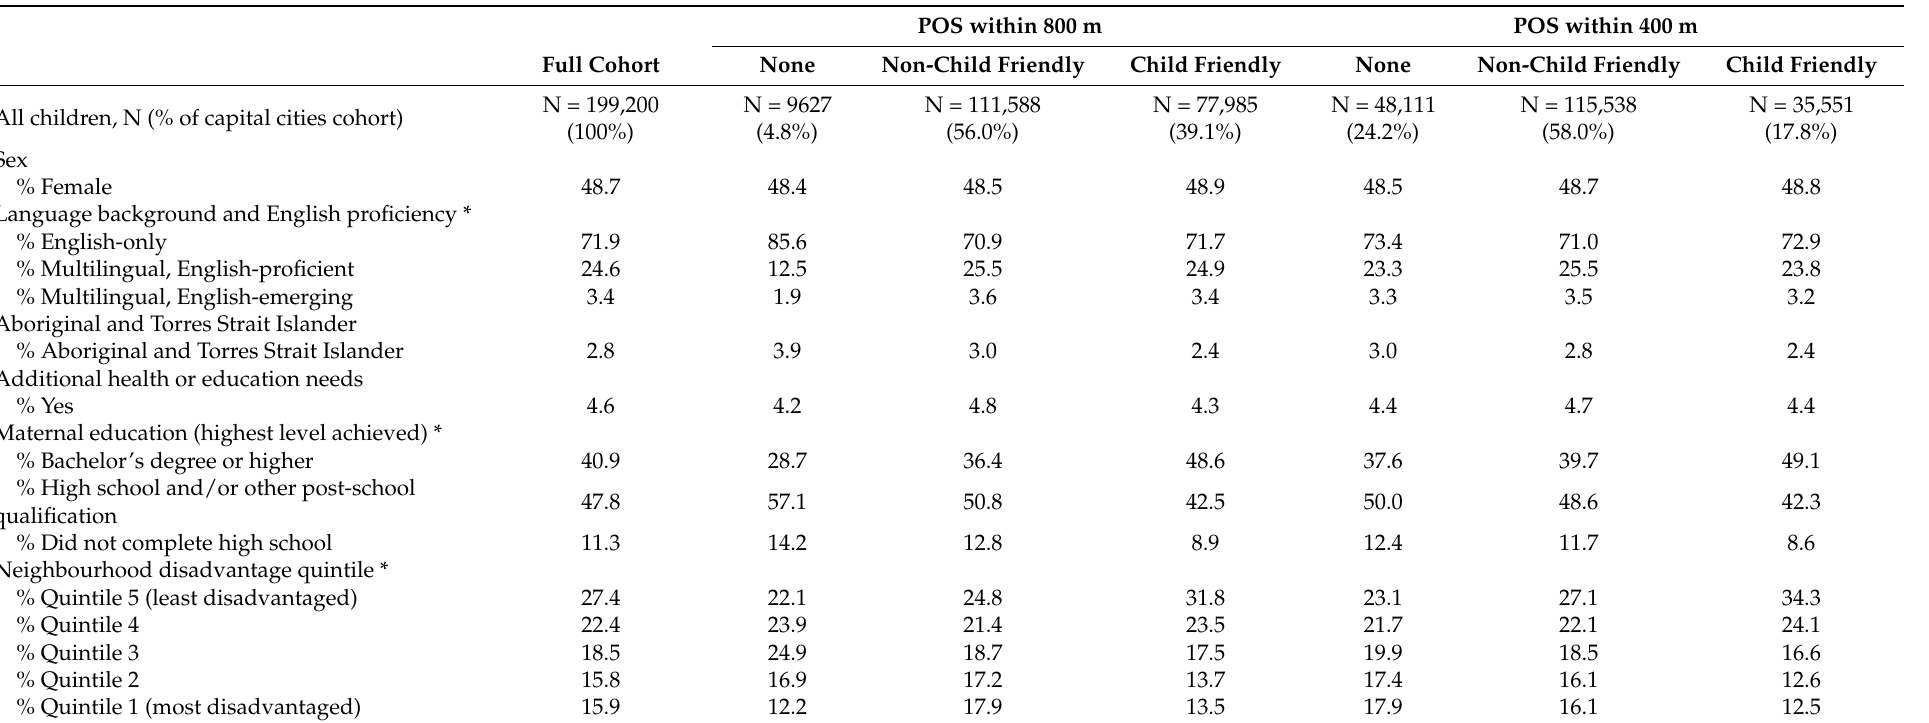
Table 1. AEDC-BE capital cities cohort characteristics and demographic characteristics of children in each public open space access group (none, non-child friendly, or child friendly public open space within 800 m, 400 m from child’s